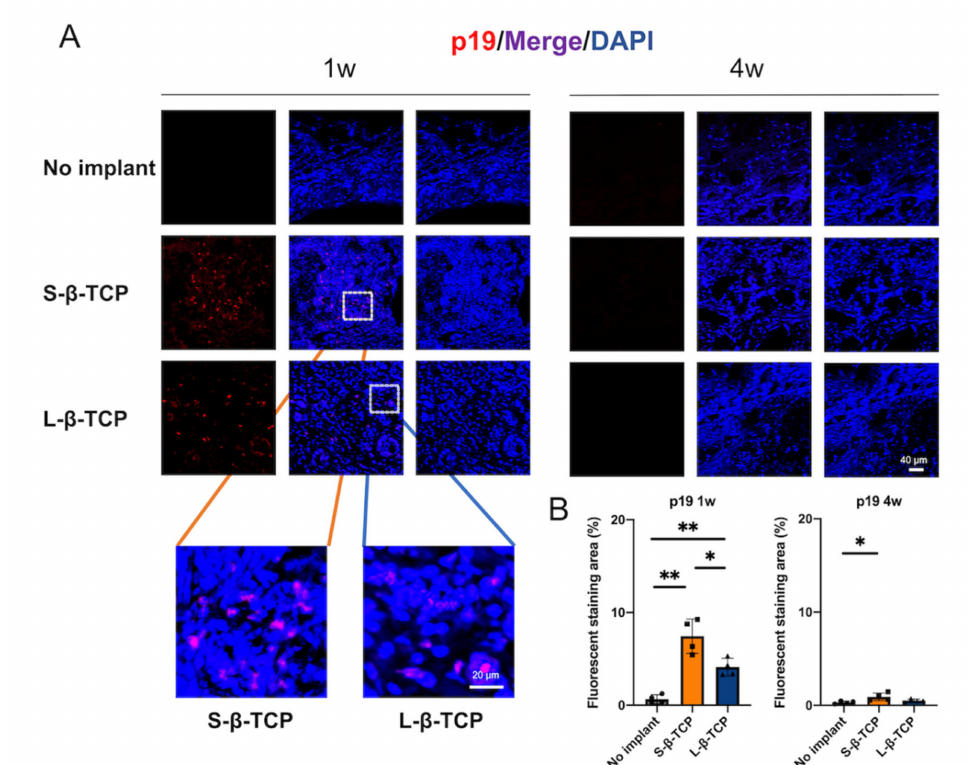
Figure 4. Identification of cellular senescence in bone defects at one week and four weeks after the operation. ( A ) Immunofluorescent images of bone defects stained with p19 antibody and DAPI (scale bar = 40 µ m); ( B ) p19 quantified protein level at ROI in the bone defect. Data are presented as the ratio of protein immunofluorescent area to nucleus area. Mean with SD ( n = 4). * p < 0.05, ** p < 0.01: One-way ANOVA analysis with Tukey–Kramer method as post hoc test.